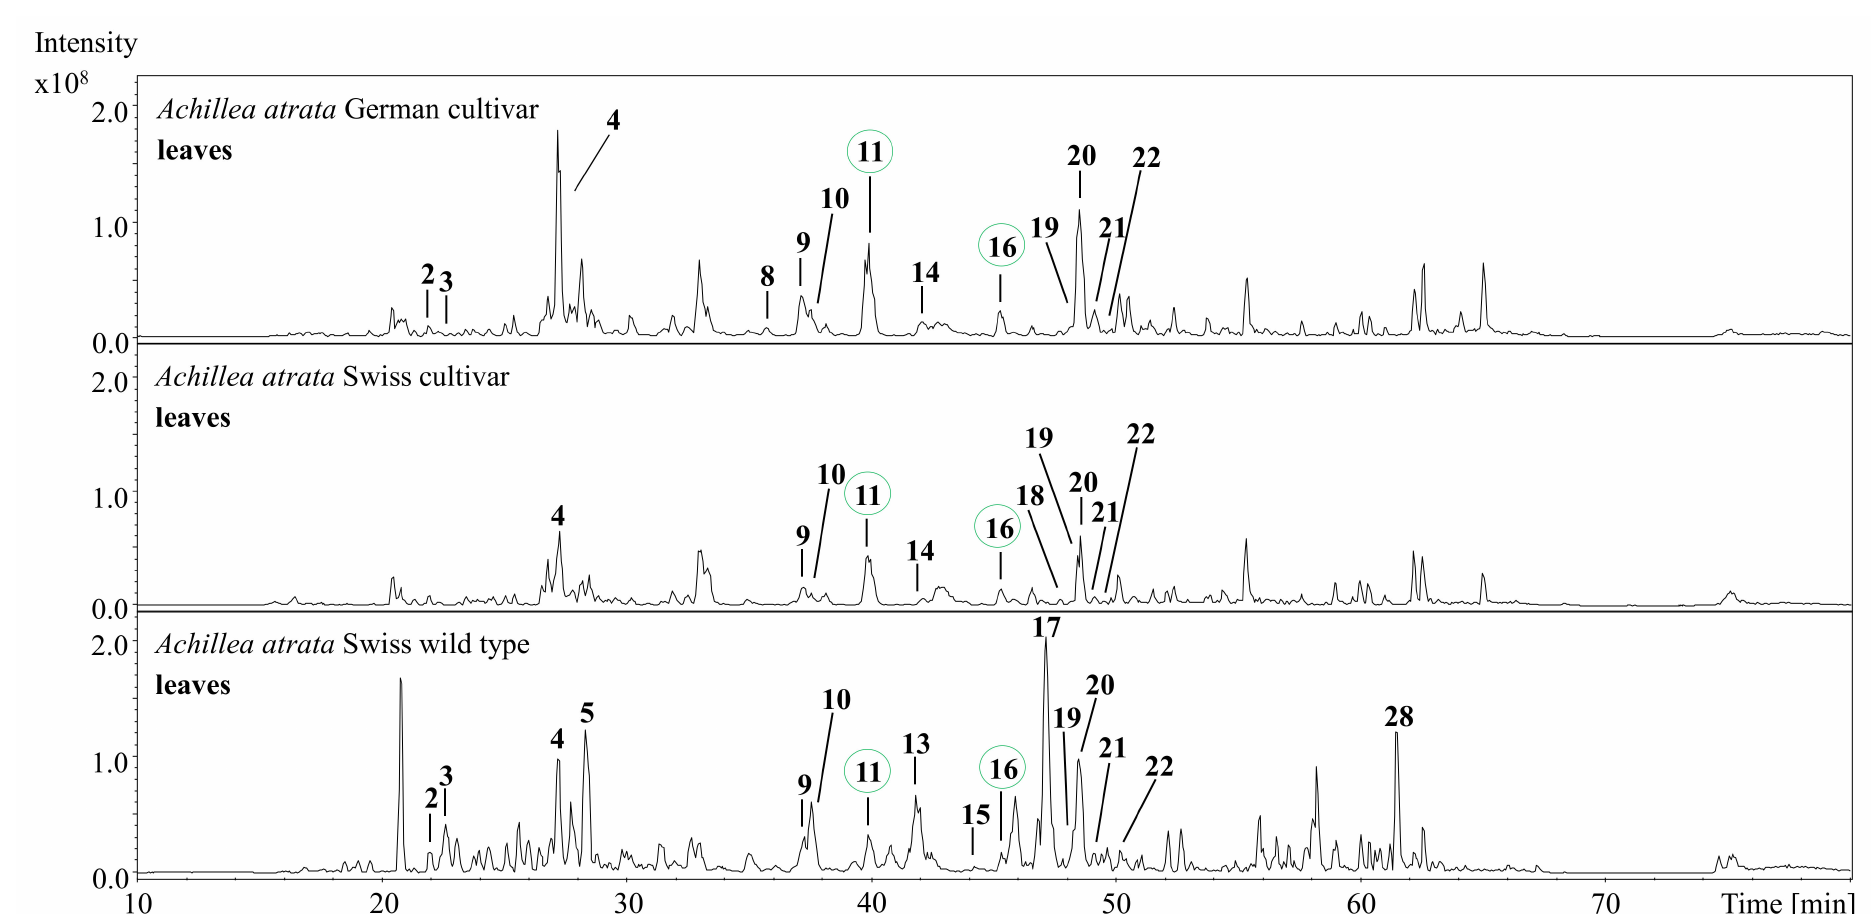
Figure 3. Comparison of total ion chromatograms of leaves extracts from A. atrata variants cultivated in Germany and Switzerland and from the wild type from Switzerland. 1 : Dimethyl- O -ellagic acid; 2 : Syringic acid- O -hexoside; 3 : Protocatechuic acid- O -hexoside; 4 : Chlorogenic acid; 5 : p -Coumaroyl acid derivative; 7 : Schaftoside/ Isoschaftoside; 8 : Quercetin- O -hexoside; 9 : Dimethoxyflavanone derivative; 10 : Formate adduct; 11 : Quercetin-3- O -rutinoside; 13 : Mearnsetin-hexoside; 14 : Luteolin- O -hexoside; 15 : Isorhamnetin- O -hexoside; 16 : Kaempferol-3- O -rutinoside; 17 : Dimethoxy-myricetin-hexoside; 19 – 23 : Dicaffeoylquinic acids; 24 : Caffeoyl-feruloylquinic acid; 28 : Nevadensin. Compounds exclusively detected in the leaves but not in flowers are highlighted in